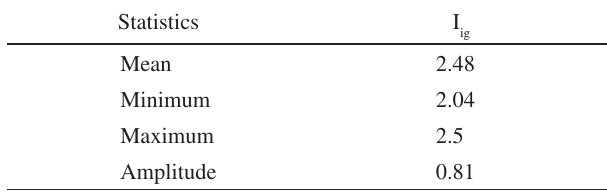
Table 1. Parameters of decay for external not treated heartwood 9 .